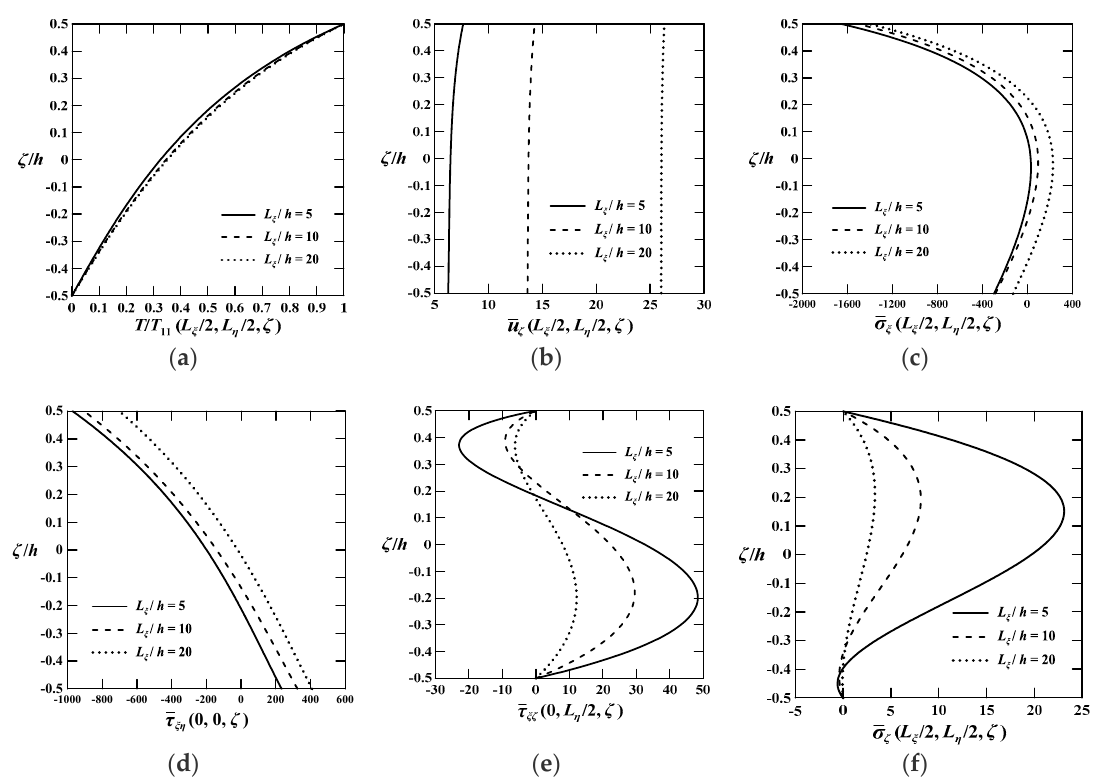
Figure 6. Through-thickness distributions of thermal and elastic field variables induced in an FGDC shell with different values of ( L ξ / h ). ( a ) Temperature; ( b ) Out-of-surface displacement; ( c ) In-surface normal stress; ( d ) In-surface shear stress; ( e ) Transverse shear stress; ( f ) Transverse normal stress.